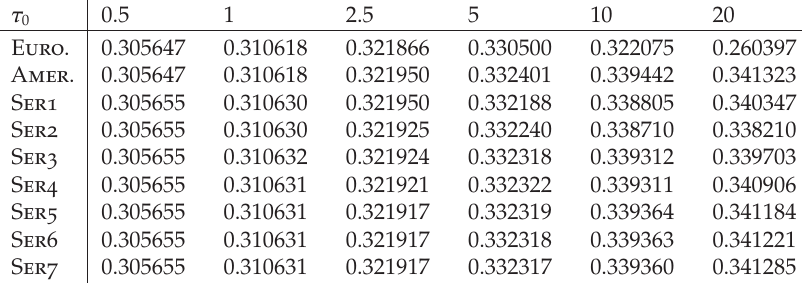
Table 2.2 . Call: Run 2; as in Table 2.1 but S D = 0 . 1, and σ = 0 . 0